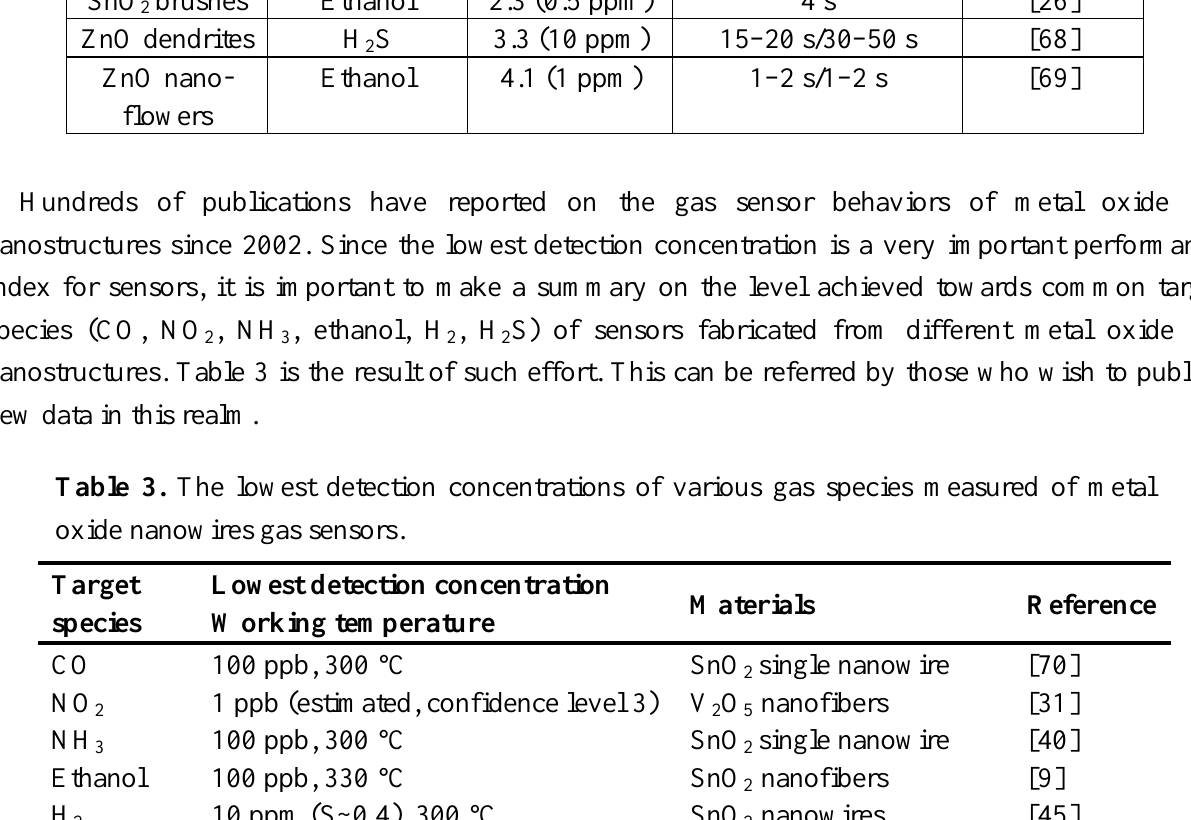
brushes [28]. (c) ZnO dendrites [68]. 2